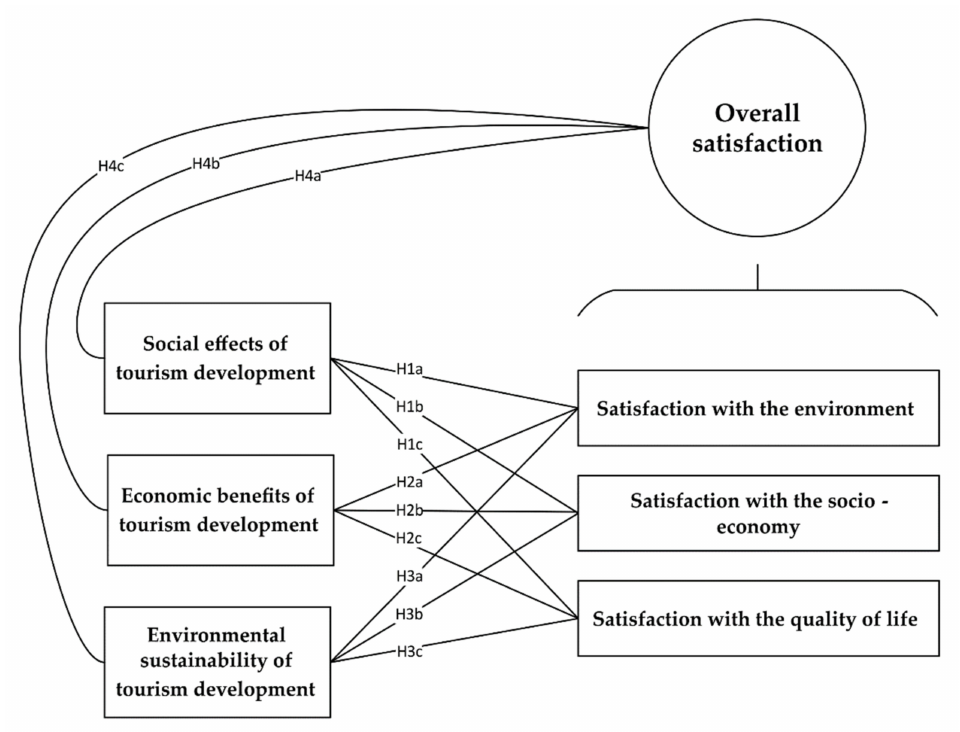
Figure 1. The research hypotheses of the current